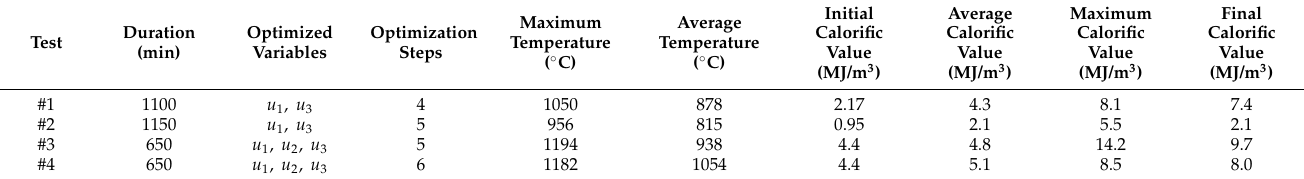
Table 2. Configuration of experiments and summary of